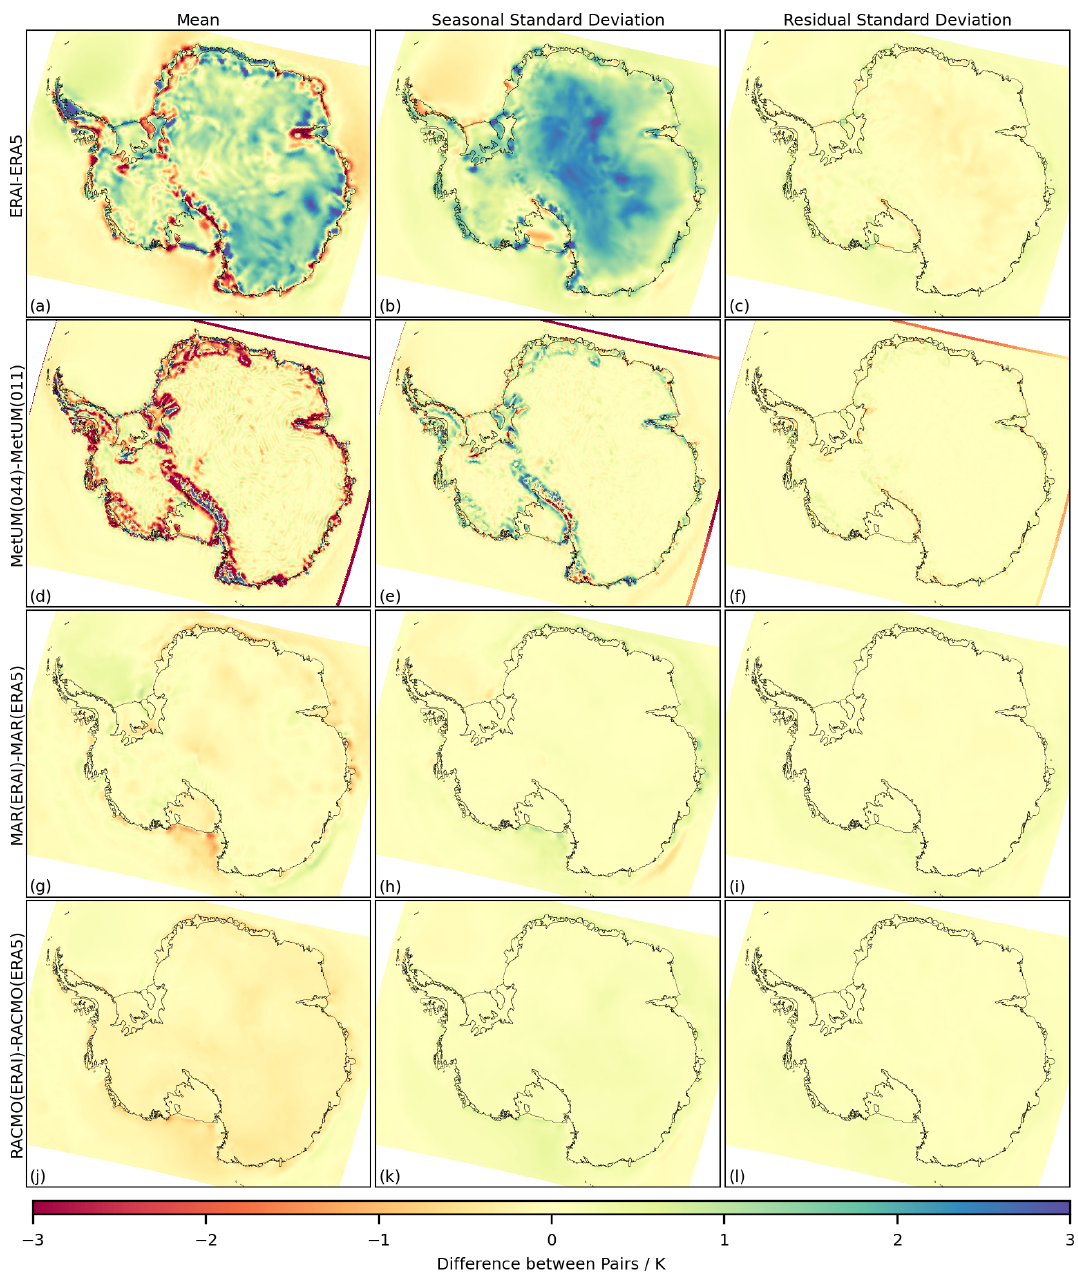
Figure B2. The difference for the 1981–2018 time series of near-surface air temperature, in the mean (a, d, g, j) , the standard deviation of the seasonal component (b, e, h, k) and the standard deviation of the residual component (c, f, i, l) between the following pairs of outputs: ERA-Interim relative to ERA5 (a–c) , MetUM(044) relative to MetUM(011) (d–f) , MAR(ERAI) relative to MAR(ERA5) (g–i) and RACMO(ERAI) relative to RACMO(ERA5) (j–l)